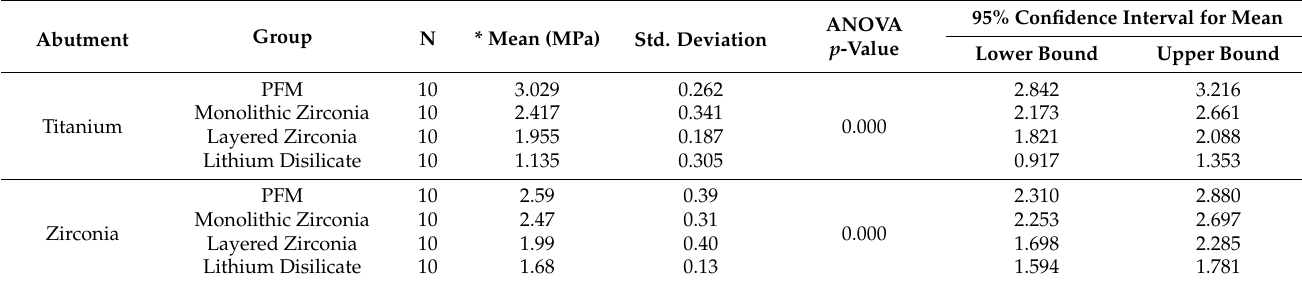
Table 2. Descriptive statistics with mean, standard deviation, and ANOVA results of the fracture resistance for all tested groups (N = 40).